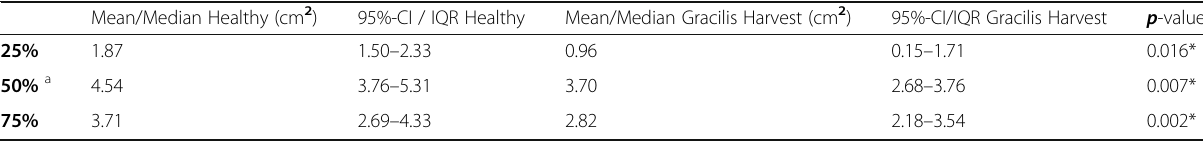
Table 5 Cross-sectional area of gracilis